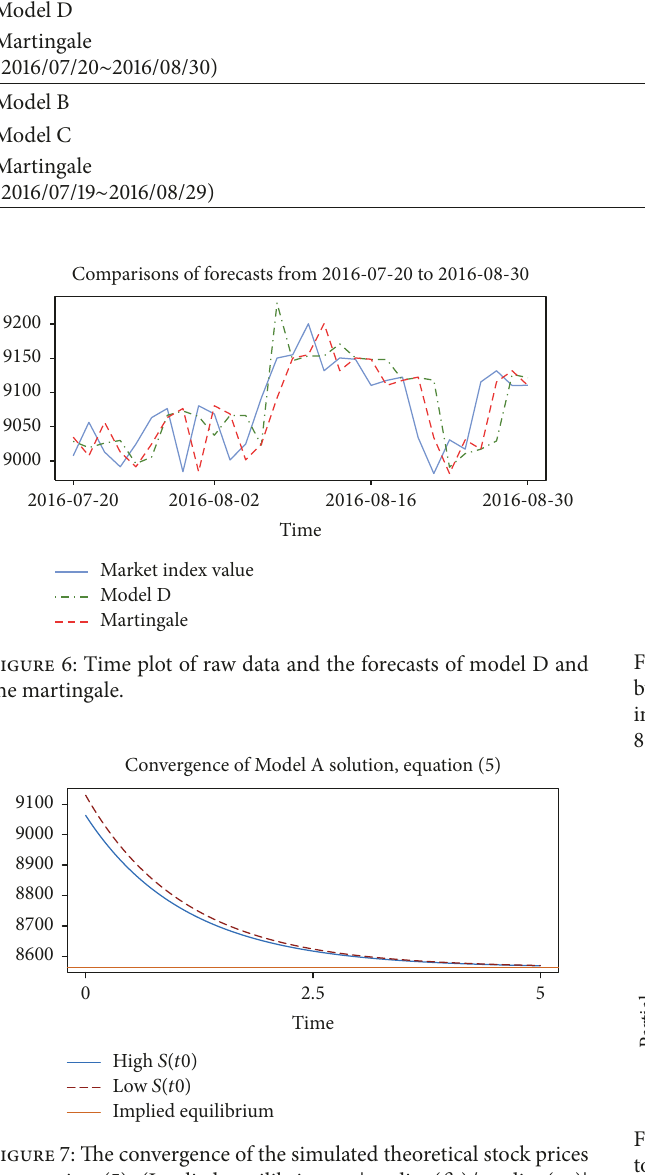
Figure 7: The convergence of the simulated theoretical stock prices by equation (5). (Implied equilibrium = | median (𝛽 1 )/ median (𝛼 1 )| = 8563.101 high stock index initial value 𝑆(𝑡 0 ) = 8563.101 + 500 = 9063.101; low stock index initial value 𝑆(𝑡 0 ) = 8563.101 – 500 = 8063.101).